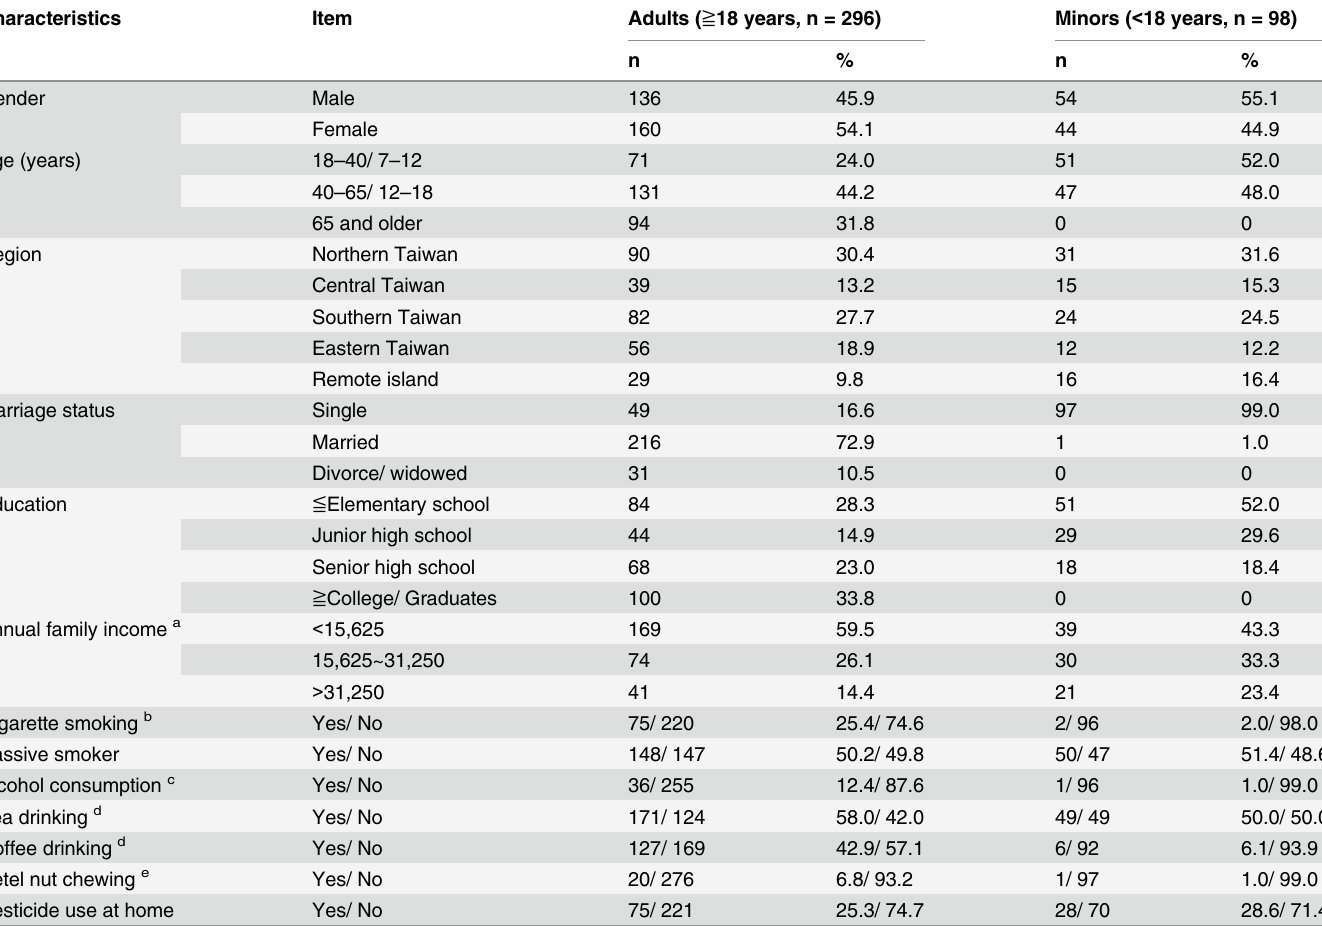
Table 1. Demographic characteristics of all participants in this study (N = 394).